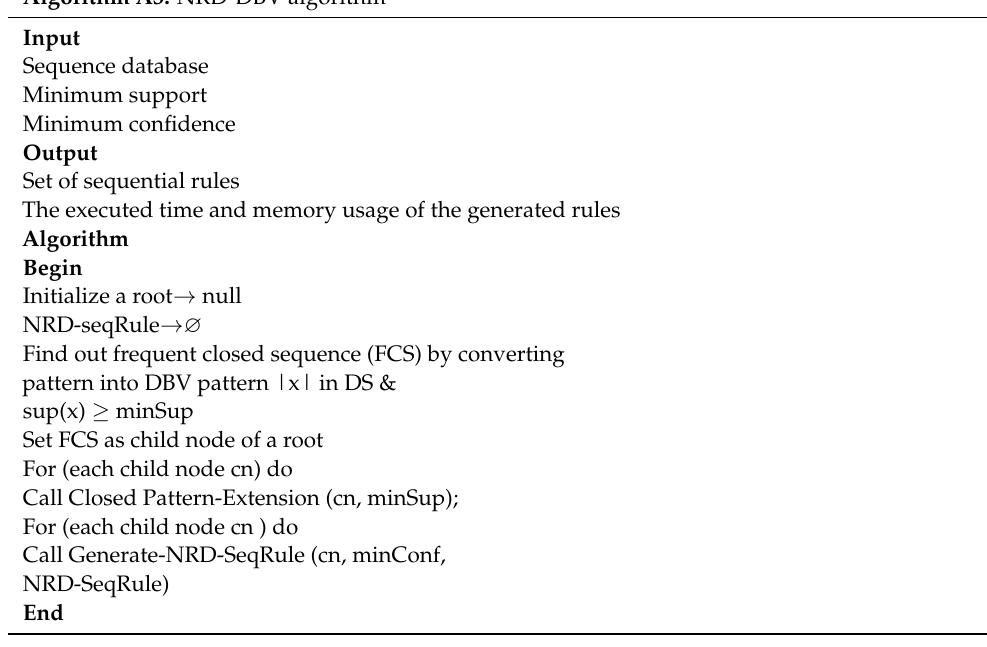
Algorithm A3: NRD-DBV algorithm